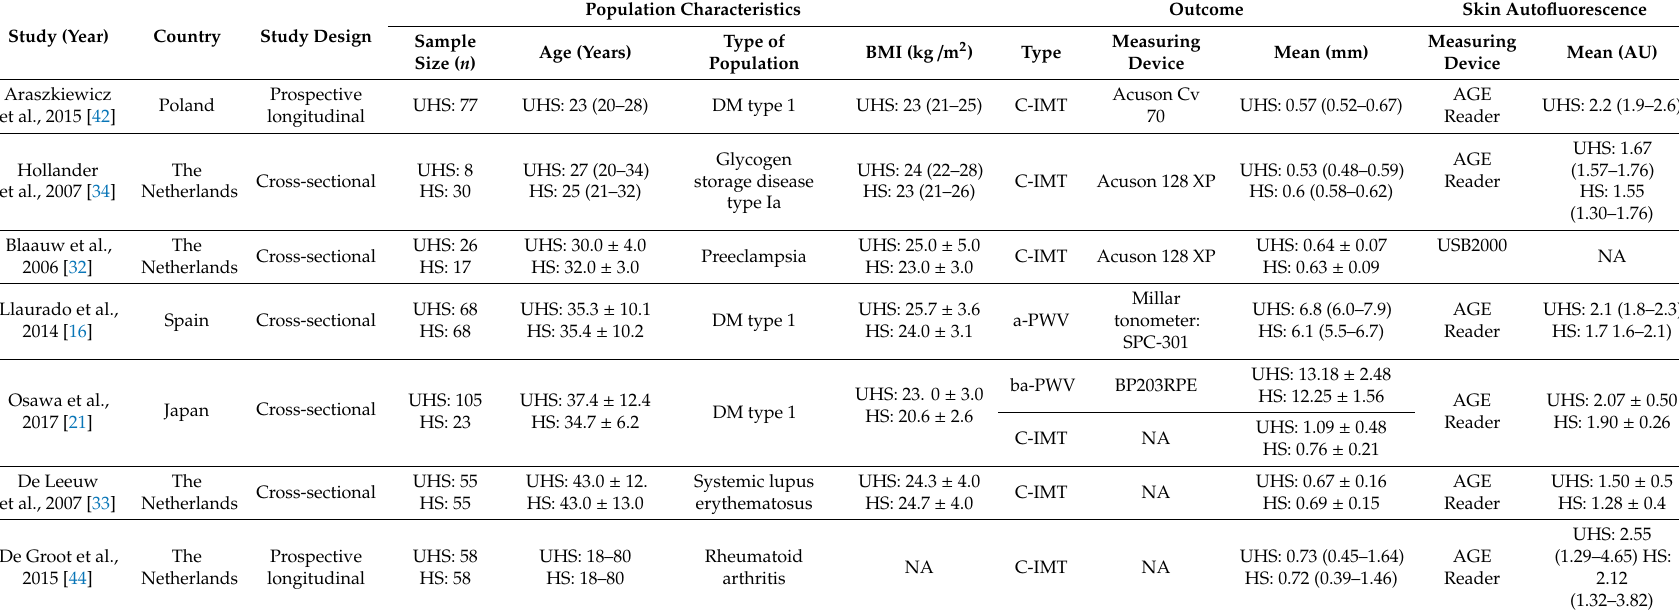
Table 1. Characteristics of the studies included in the systematic review and meta-analysis of the relationship between pulse wave velocity or carotid intima media thickness and skin